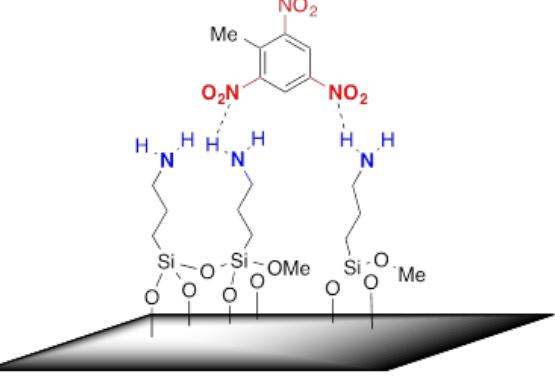
Figure 9. Schematic diagram, representing the surface modified with 3-aminopropyltrimethoxysilane and its sensitive binding mechanism to TNT